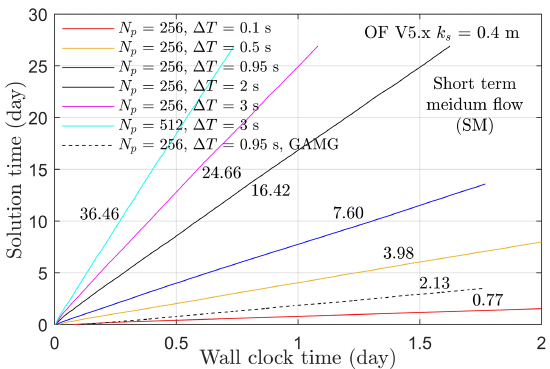
Figure 14. The advancement of solution time with respect to wall- clock time. N p and (cid:49)T denote the number of processors and time step. The linear solvers represented by solid and dashed lines are DIC-PCG and GAMG, respectively. The line slope or the computa- tional efficiency is denoted by the values adjacent to each